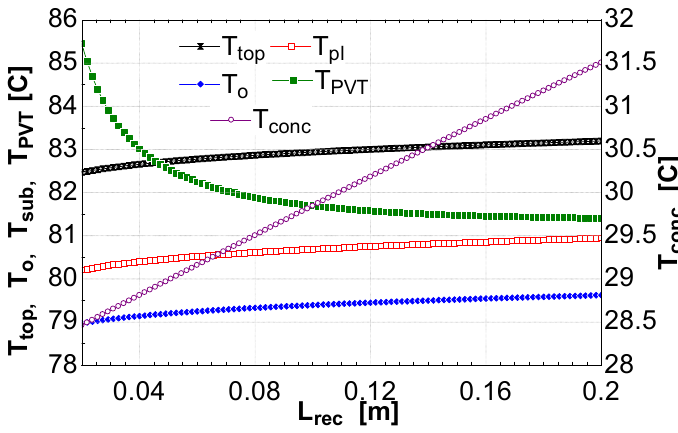
Figure 10. CPVT Temperatures vs. receiver length.